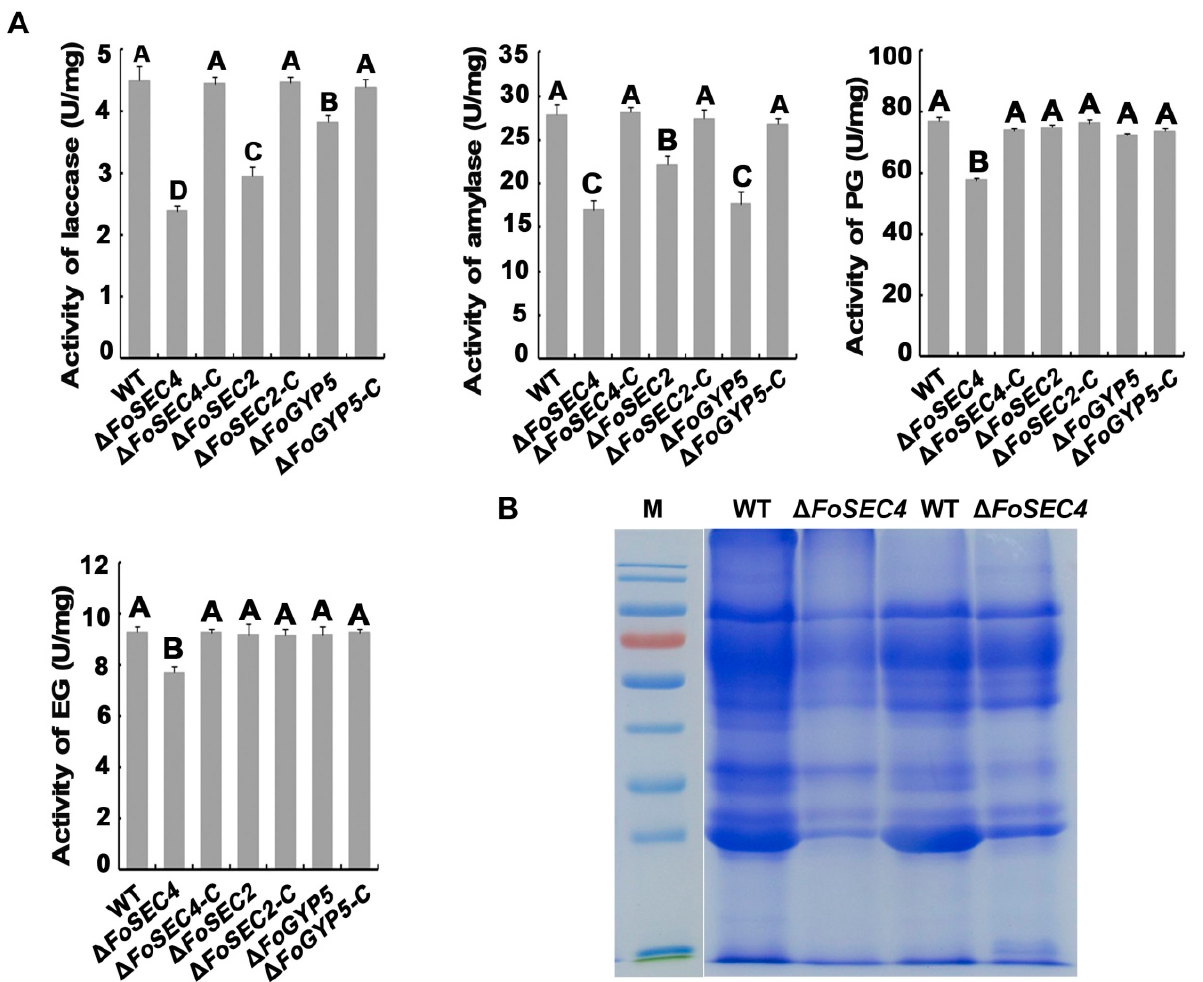
Figure 6. FoSec4, FoSec2 and FoGyp5 are required for protein secretion in F. odoratissimum . ( A ) The activities of laccase, amylase, polygalacturonase (PG) and endoglucanase (EG) secreted from the indicated strains after 7 days of cultivation in modified Czapek–Dox medium were detected using the DNS method. The error bars represent the standard deviation (SD) of three replicates, and the values on the bars followed by the same letter are not significantly different at p = 0.01. ( B ) Coomassie brilliant blue gel of secreted proteins from the wild-type (WT) and Δ FoSEC4 strains cultured for 3 days in modified Czapek–Dox liquid medium, in which sucrose was replaced with apple pectin.